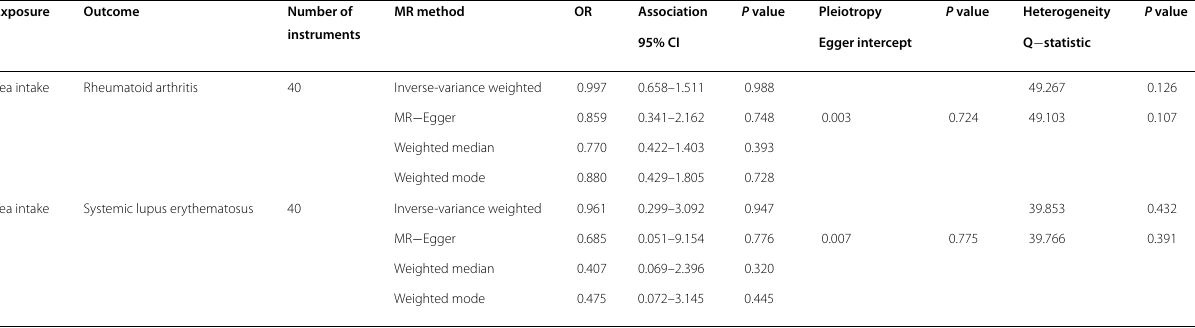
Table 1 Univariable MR estimates of genetically predicted tea intake on the risk of rheumatoid arthritis and systemic lupus